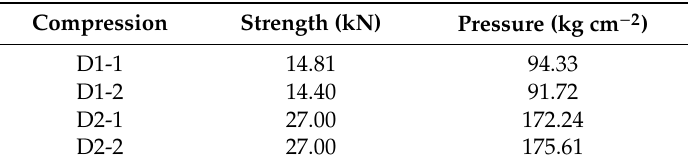
Table 7. Compression strength assay results after 28 days.